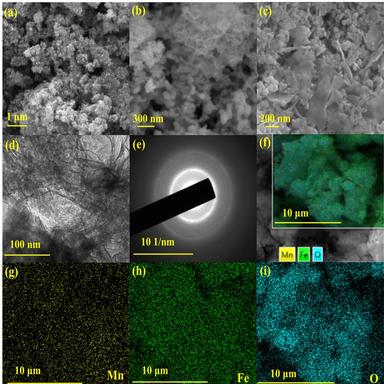
The morphological characteristics of the nZVIM particles: (a), (b) SEM images; (c), (d) TEM images; (e) SAED images; (f), (g), (h) and (i) SEM-EDS elemental mapping images (Green: Fe, yellow: Mn, cyanine: O) (For interpretation of the references to colour in this figure legend, the reader is referred to the web version of this article).